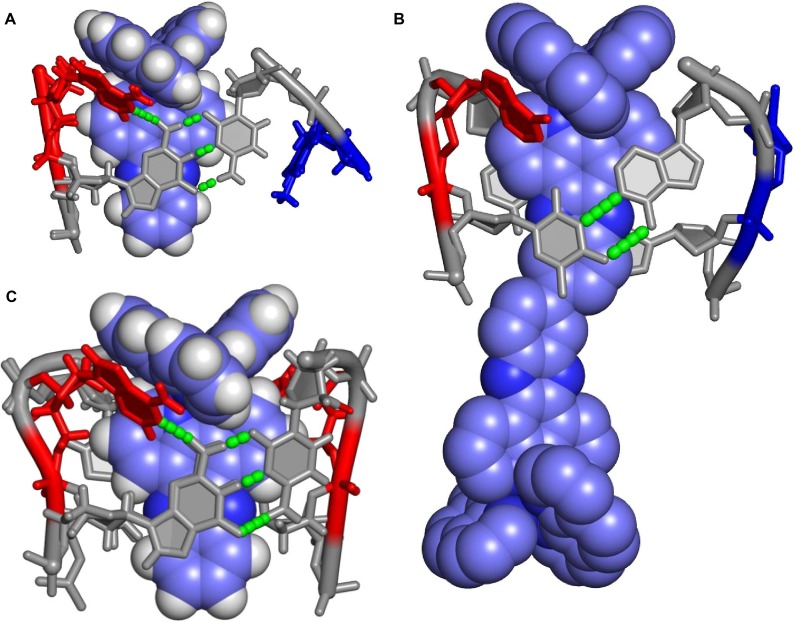
A comparison of the binding sites for Δ Ru-polypyridyls in DNA. (A) The binding site in the present work. Δ-[Ru(phen)2(dppz)]2+ binds into d(TCGGCGCCGA)2 at the terminal step, with T1 and A10 flipped out. A10 stacks onto an ancillary phen group. (B) A similar binding motif crystallised in the threading of Δ,Δ-[μ-(11,11′-bidppz)(phen)4Ru2]4+ at the TA/TA step of d(CGTACG)2. Both (B)T3 and (A)A4 are flipped out, with (A)A4 stacking on an ancillary phen group. (C) Δ-[Ru(bpy)2(dppz)]2+ crystallised at an AA mismatch site, with both adenine bases flipped out and stacked on the bpy ligand groups from the complex (PDB ID 4E1U). In all three structures, a hydrogen bond is formed between the flipped adenine and a G(NH2) on the 5′ side of the binding site, although this not adjacent to the threading cavity with Δ,Δ-[μ-(11,11′-bidppz)(phen)4Ru2]4+ (PDB ID 4GQJ). In this figure, adenine bases are drawn in red with thymine bases in blue. The atoms in the complex are coloured according to type with nitrogen in deep blue, carbon in light blue and hydrogen in white. Other DNA bases are drawn in grey. Hydrogen bonds between the bases are drawn as dashed lines in green.